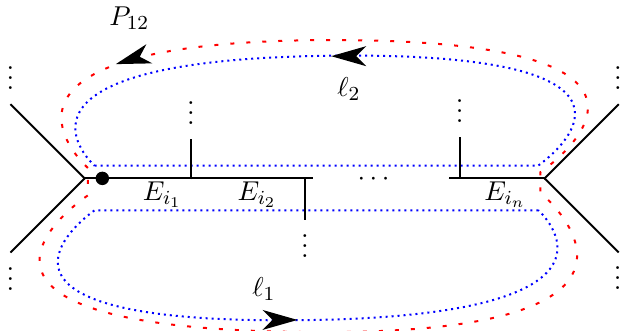
Figure 25. Two loops ‘ 1 and ‘ 2 from the homology basis (shown as blue dotted curves) intersect along a chain of edges E i ; : : : ; E i . Here, their orientations are opposite where they intersect. The 1 n red dashed curve is the reduced path P 12 = P 1 (cid:1) P 2 (where P j is the path corresponding to the loop ‘ j ). It crosses all the edges that ‘ 1 and ‘ 2 do, with the exception of E i